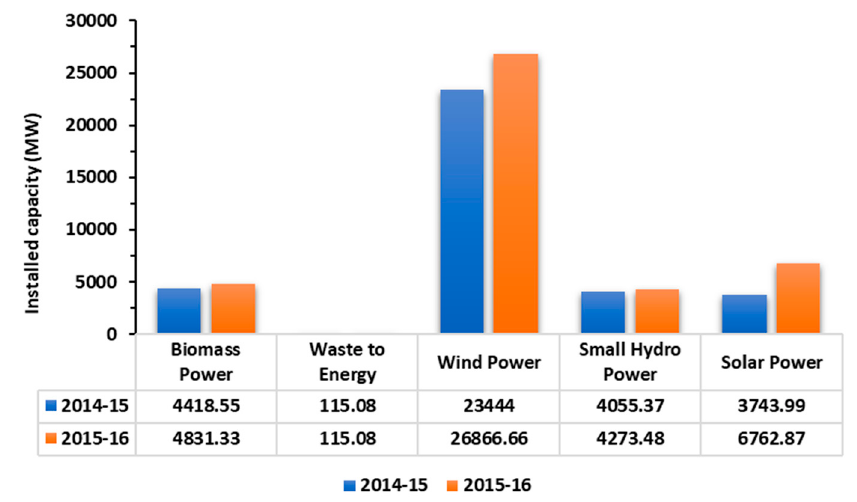
Figure9. Figure 9. Data analysis of the installed capacity of the grid-interactive renewable power for 2015–2016 [4].